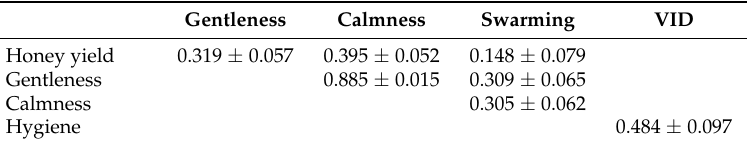
Table 4. Genetic correlations and their standard